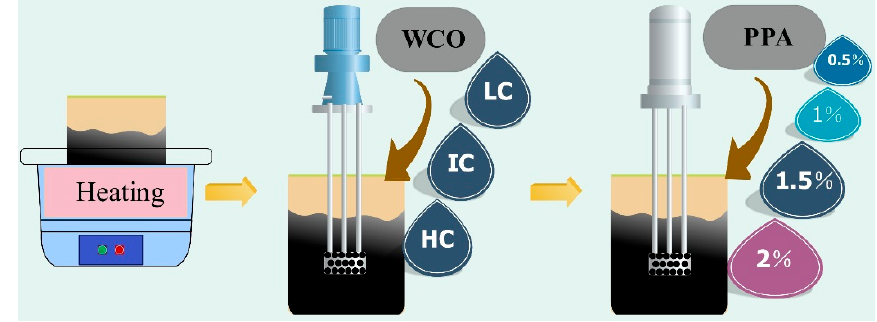
Figure 2. The preparation process of WCO\PPA-modified bitumen.